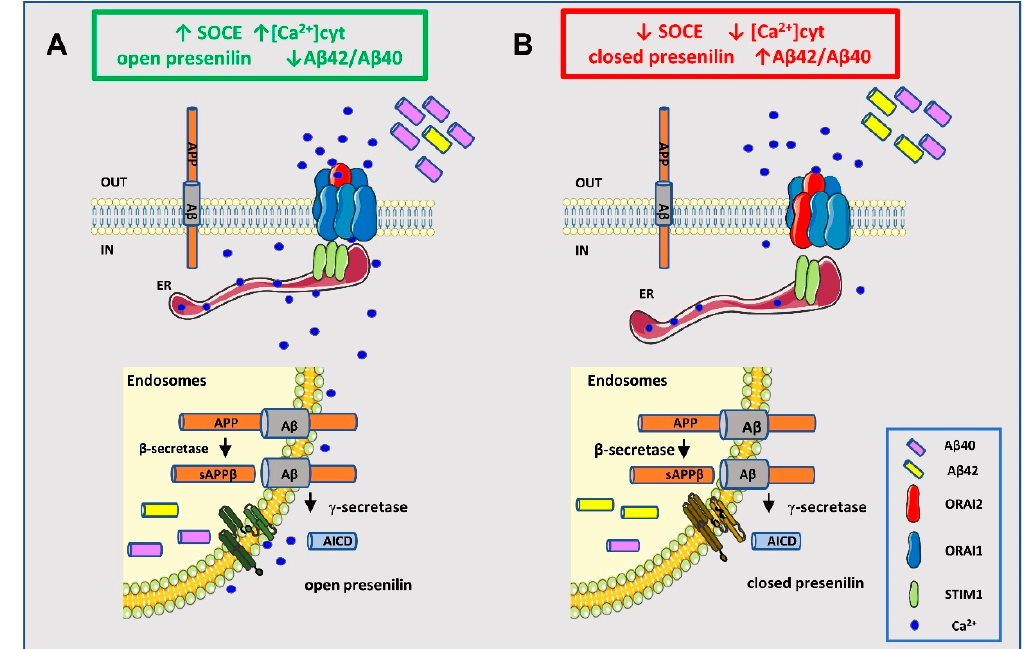
Figure 8. Hypothetical model of the crosstalk between SOCE and A β production. ( A ) Higher SOCE levels by ORAI2 downregulation increase the cytosolic Ca 2 + concentration, favouring the open conformation of presenilin and the accumulation of the shorter peptide A β 40 (74,75).( B ) Lower SOCE levels, caused by inhibitors or by reduced STIM1 availability, as observed in AD (12,13,70), favour the closed conformation of presenilin with the accumulation of the longer peptide A β 42; AICD (APP intracellular domain).